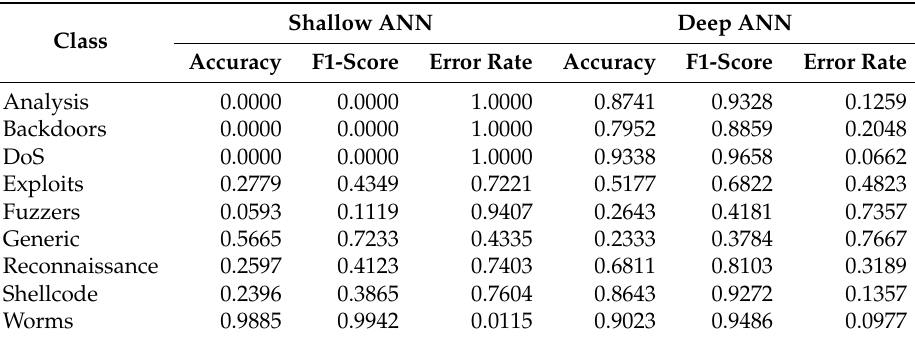
Table 6. Error rate for Type-A multi-class models using the UNSW-NB15